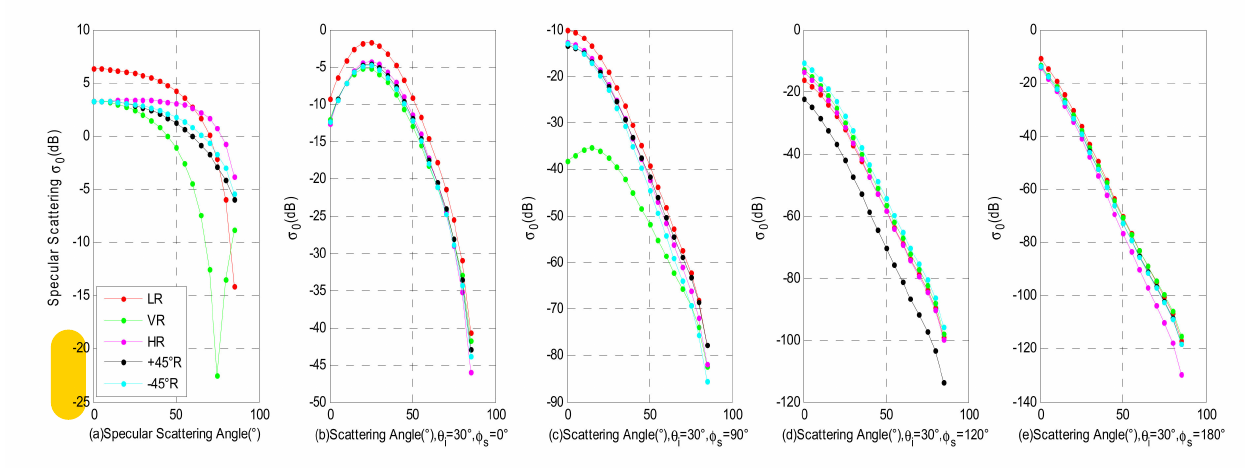
Figure 3. Scattering properties of different polarization versus the specular/scattering angles: ( a ) Specular scattering; ( b ) bistatic scattering in one-plane θ i = 30 ◦ , ϕ s = 0 o ; ( c ) bistatic scattering in Perpendicular plane θ i = 30 ◦ , ϕ s = 90 o ; ( d ) bistatic scattering θ i = 30 ◦ , ϕ s = 120 o ; ( e ) bistatic scattering θ i = 30 ◦ , ϕ s = 180 o .